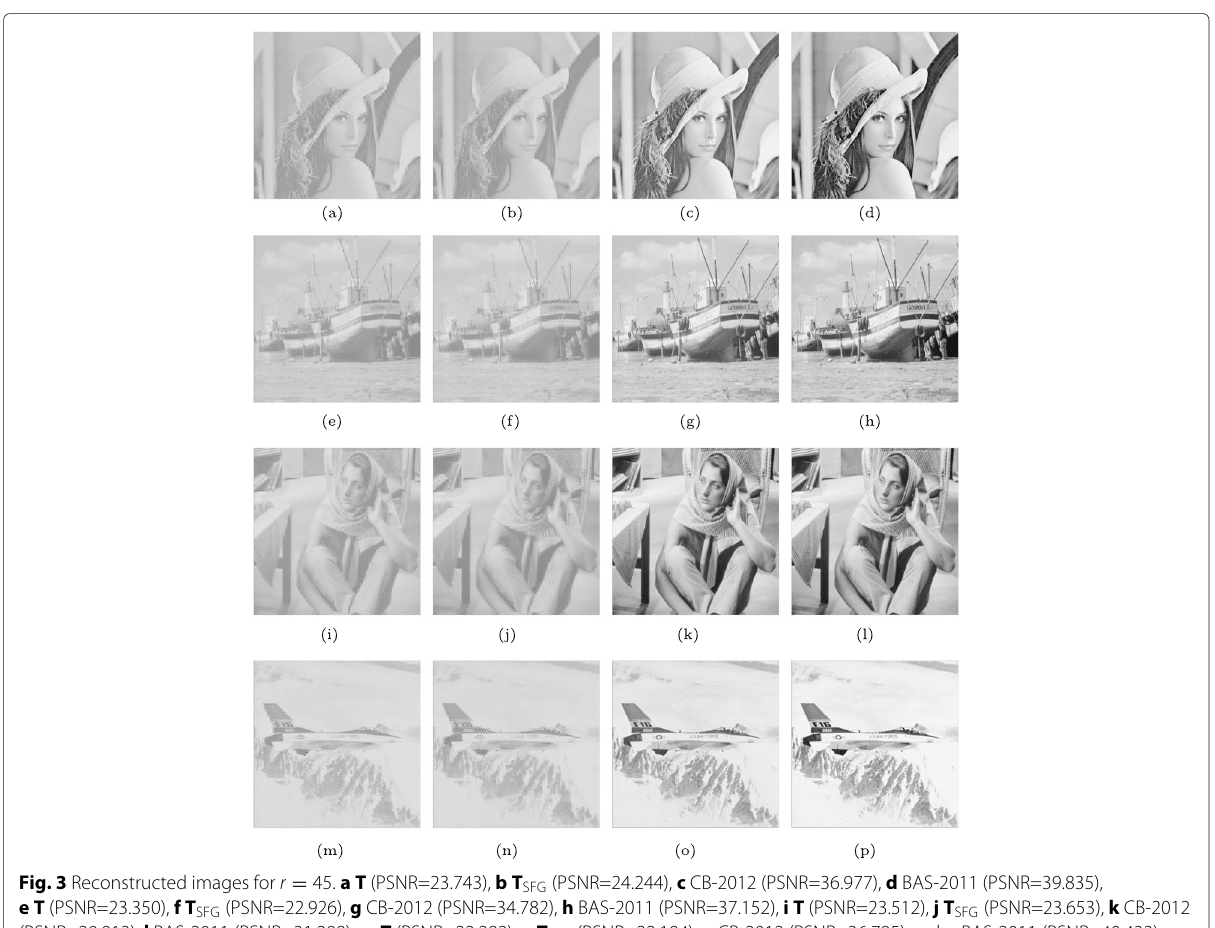
Fig. 3 Reconstructed images for r = 45. a T (PSNR=23.743), b T SFG (PSNR=24.244), c CB-2012 (PSNR=36.977), d BAS-2011 (PSNR=39.835), e T (PSNR=23.350), f T SFG (PSNR=22.926), g CB-2012 (PSNR=34.782), h BAS-2011 (PSNR=37.152), i T (PSNR=23.512), j T SFG (PSNR=23.653), k CB-2012 (PSNR=29.913), l BAS-2011 (PSNR=31.298), m T (PSNR=22.282), n T SFG (PSNR=22.184), o CB-2012 (PSNR=36.785) and p BAS-2011